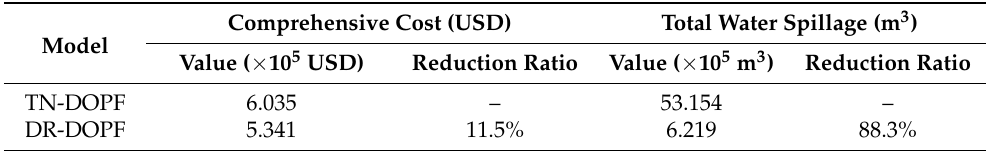
Table 4. Comparison of TN-DOPF and DR-DOPF